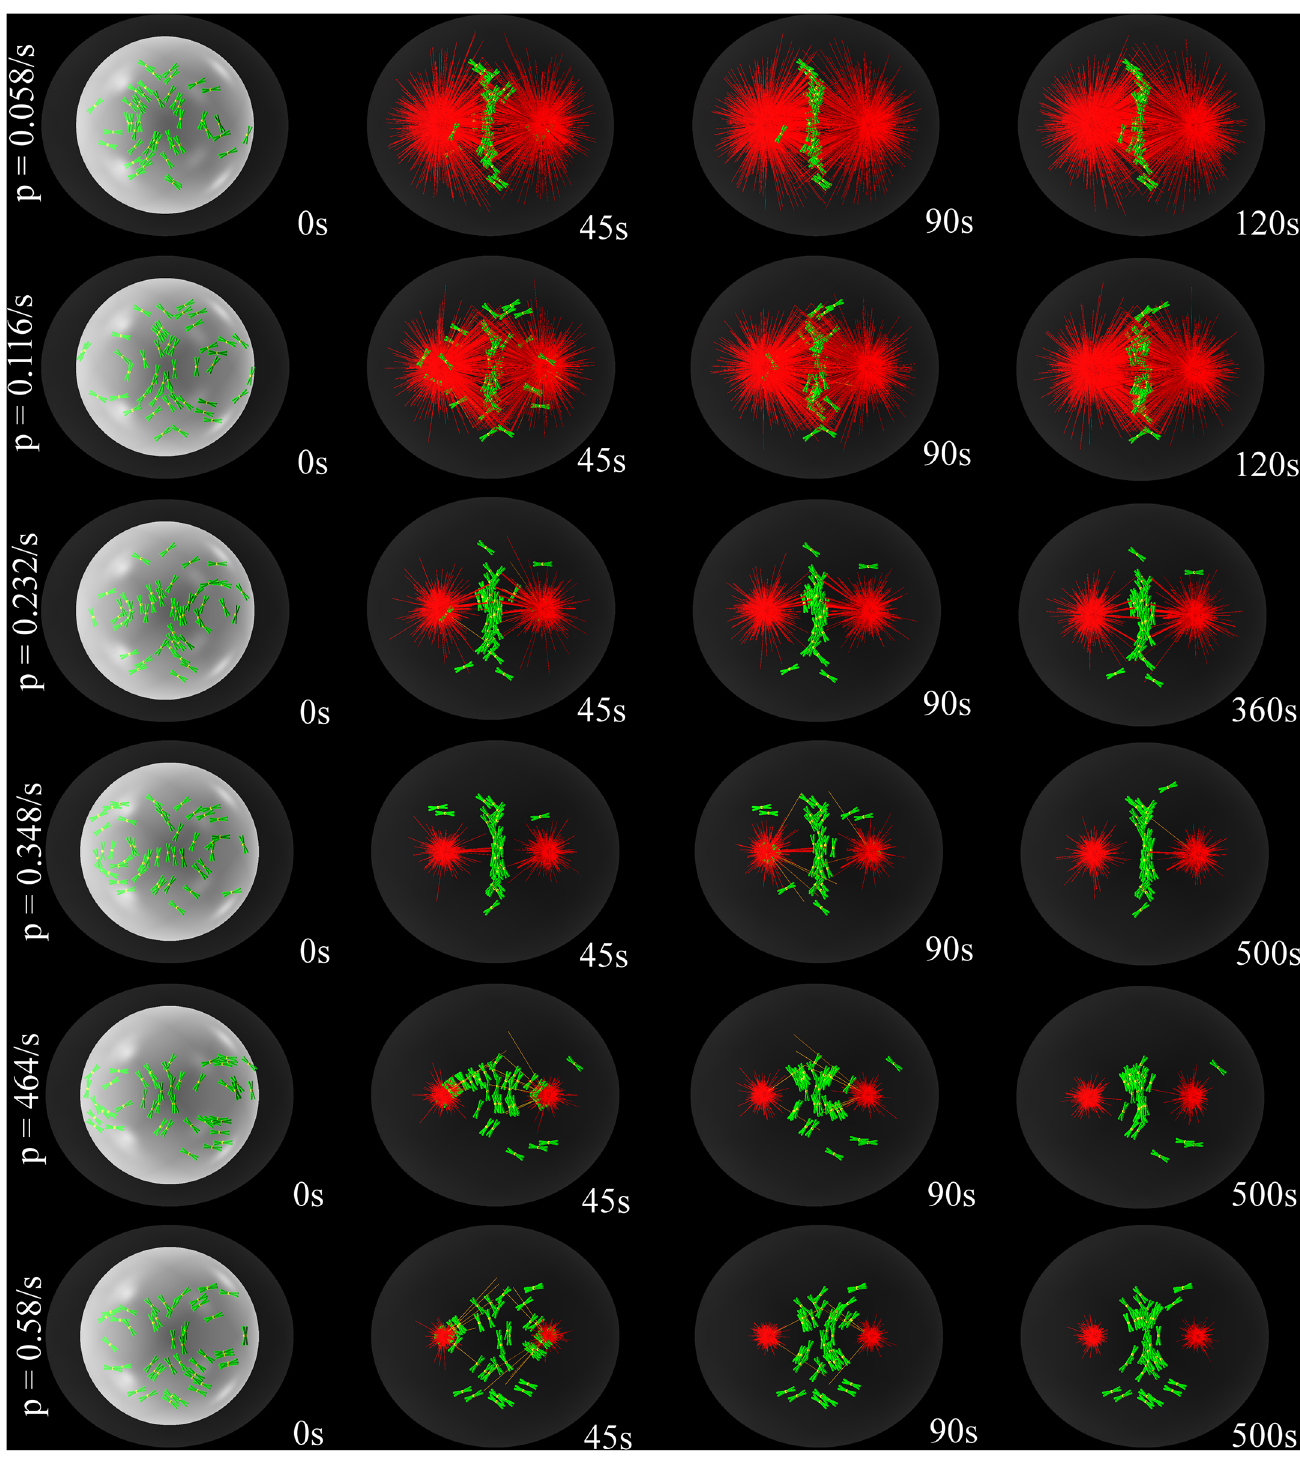
Fig 7. Time-lapse snapshots of the simulated congression process for different values of the rate of MT catastrophes p 0 cat . Large values of p 0 cat , that is, overexpression of MT depolymerases, lead to unsuccessful congression. The nuclear envelope is shown for reference in each of the fi rst panels as a white sphere. The cortex is represented in dark grey.